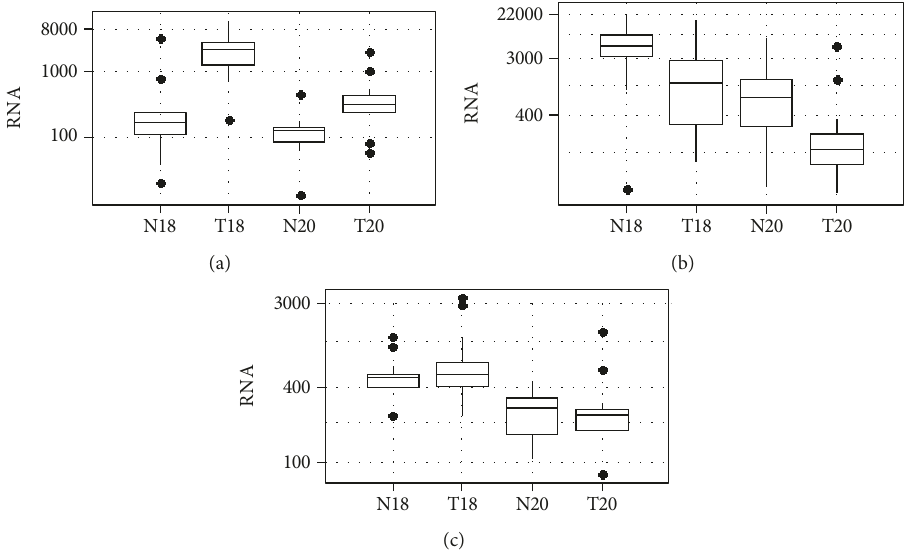
Figure 2: Logarithmic scale of RNA content by tissue type and needle gauge in (a) lung tumors, (b) liver tumors, and (c) kidney tumors (N18=normal tissue/18 gauge, T18=tumor tissue/18 gauge, N20 =normal tissue/20 gauge, T20=tumor tissues/20 gauge). The dark bar is the median, the box encompasses the 25 – 75 interquartile range (IQR), the dotted brackets are 1.5 ∗ IQR, and dots are